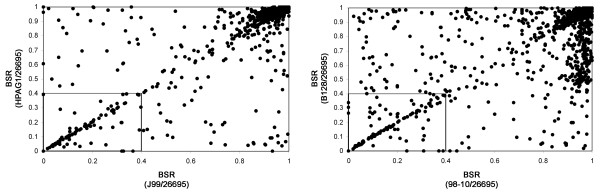
Comparison of predicted proteomes by BLAST-score ratio (BSR) analysis. The left panel shows a BSR analysis of proteins encoded by strain J99 and HPAG1, with strain 26695 as the reference strain. The right panel shows a BSR analysis of proteins encoded by strain 98-10 and B128, with strain 26695 as the reference strain. The BSR approach analyzes all proteins predicted to be encoded by three genomes, using a measure of similarity based on the ratio of BLAST scores, as described in the Methods. Proteins depicted within the box at the lower left corner (BSR <0.4) correspond to proteins present in the reference proteome (strain 26695) but absent from the two query proteomes. The upper right quadrant represents proteins conserved in all three proteomes.